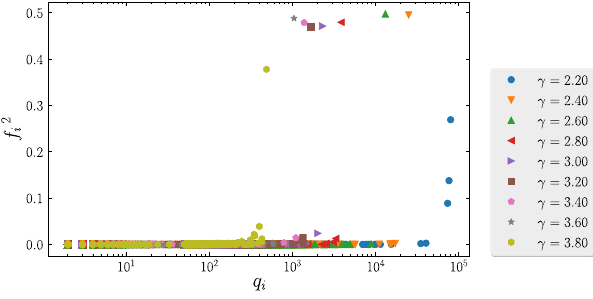
FIG. 10. Scatter plot of f 2 networks of different degree exponent γ . Network size N ¼ 10 6 .